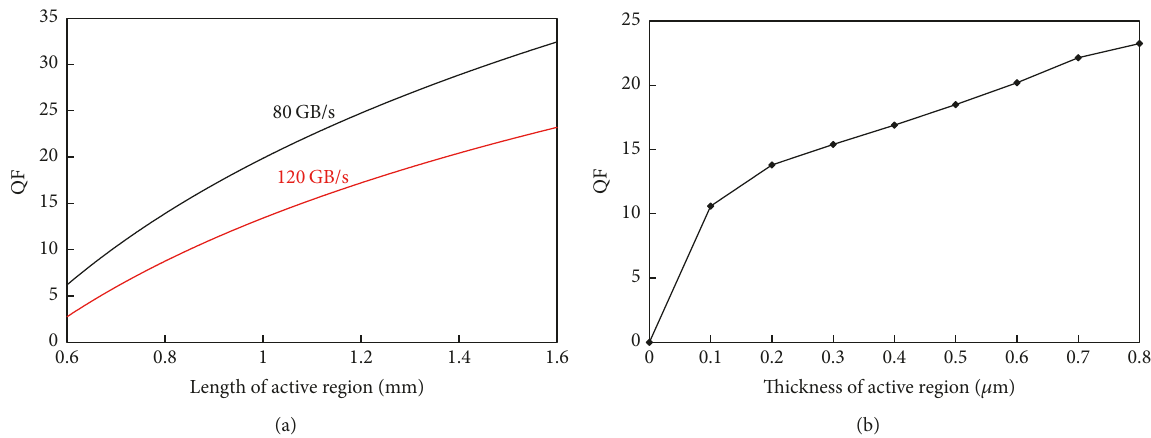
Figure 5: QF versus SOA’s active region (a) length at 80 Gb/s & 120Gb/s and (b) thickness for AND